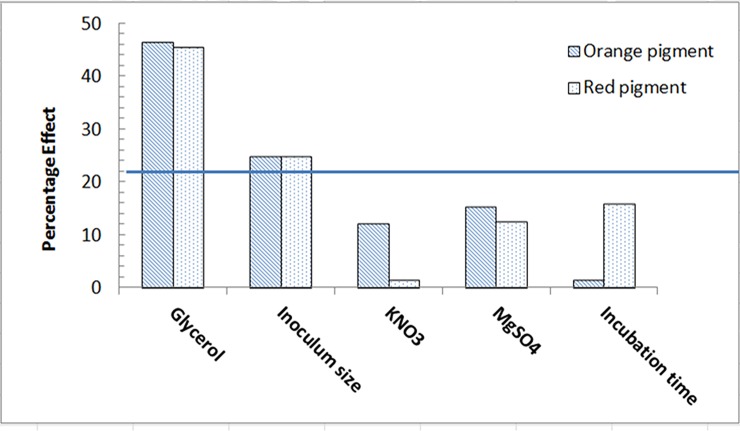
Pareto chart in a descending order concerning the significance of five tested independent variables on orange and red monascus pigments production.Solid line represents the level of significance(P<0.05).